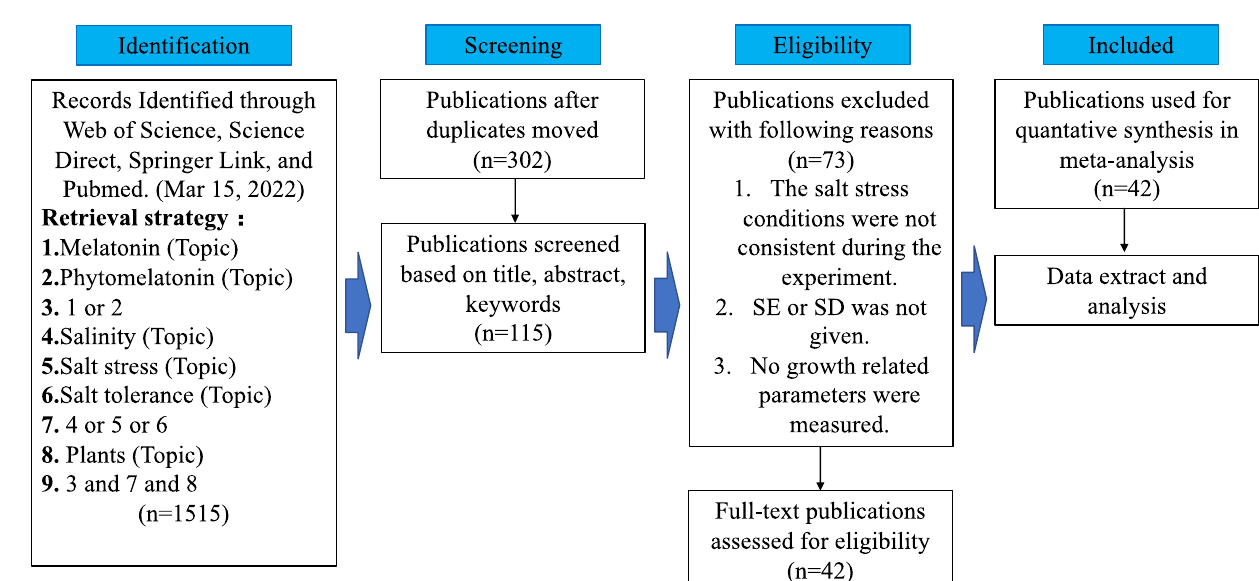
Figure 1. Flow chart for selection of publications.